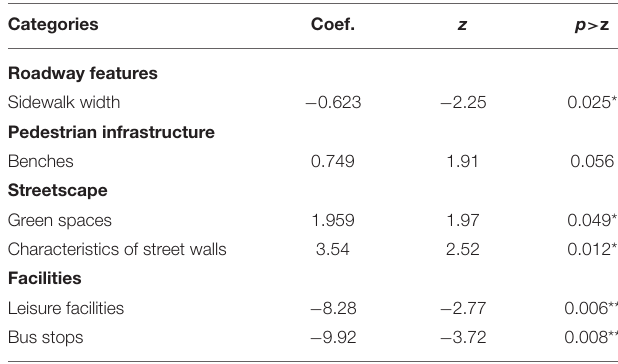
TABLE 2 | Conditional logit results of chosen and shortest route (the entire route between OD pairs). Categories